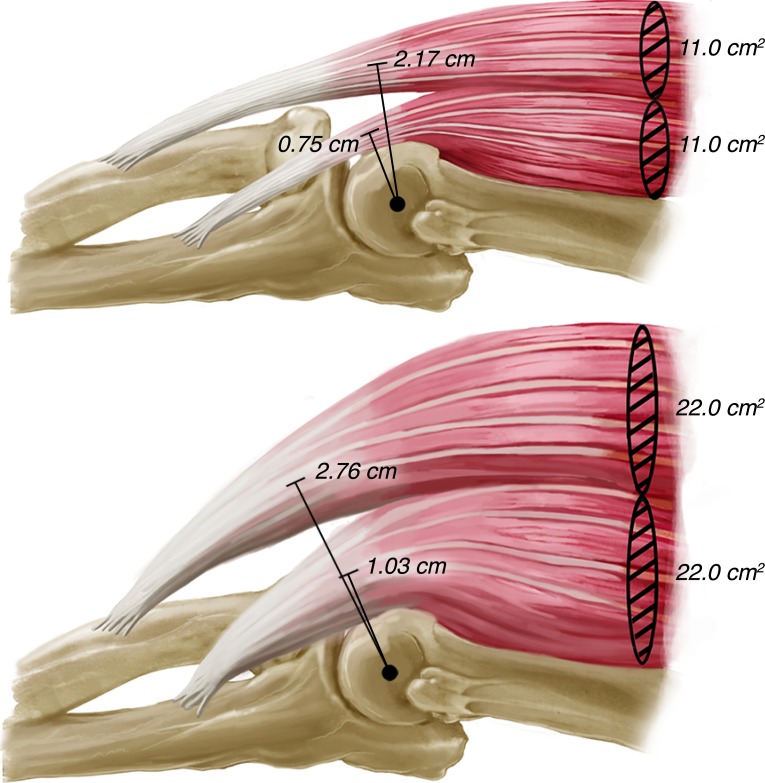
Illustration of the changes in biceps brachii and brachialis moment arm lengths with increases in anatomical cross-sectional area.By doubling the anatomical cross-sectional area of the biceps brachii and brachialis, the moment arms of each increase by 27.2% and 37.3%, respectively.